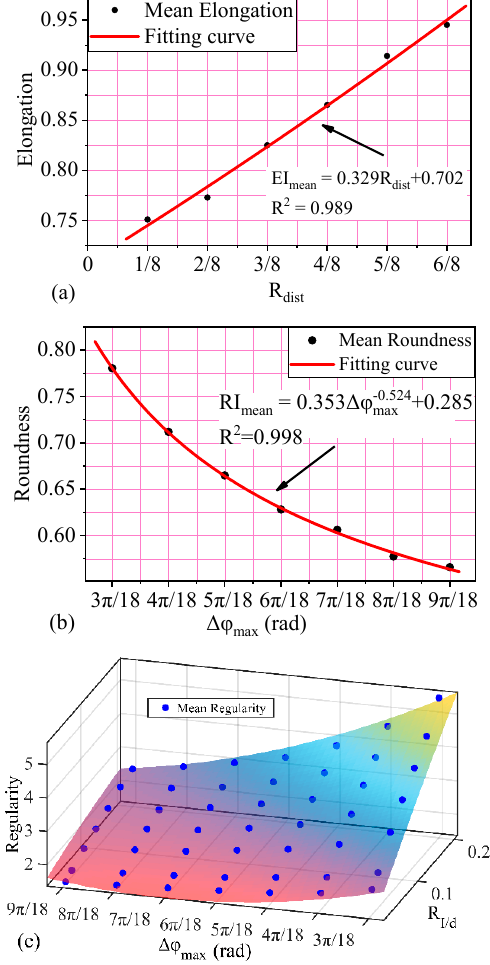
Figure 9. Relationship between input parameters and shape descriptor: ( a ) Relationship between input parameters and EI mean , ( b ) relationship between input parameters and RI mean , and ( c ) relationship between input parameters and RE mean.